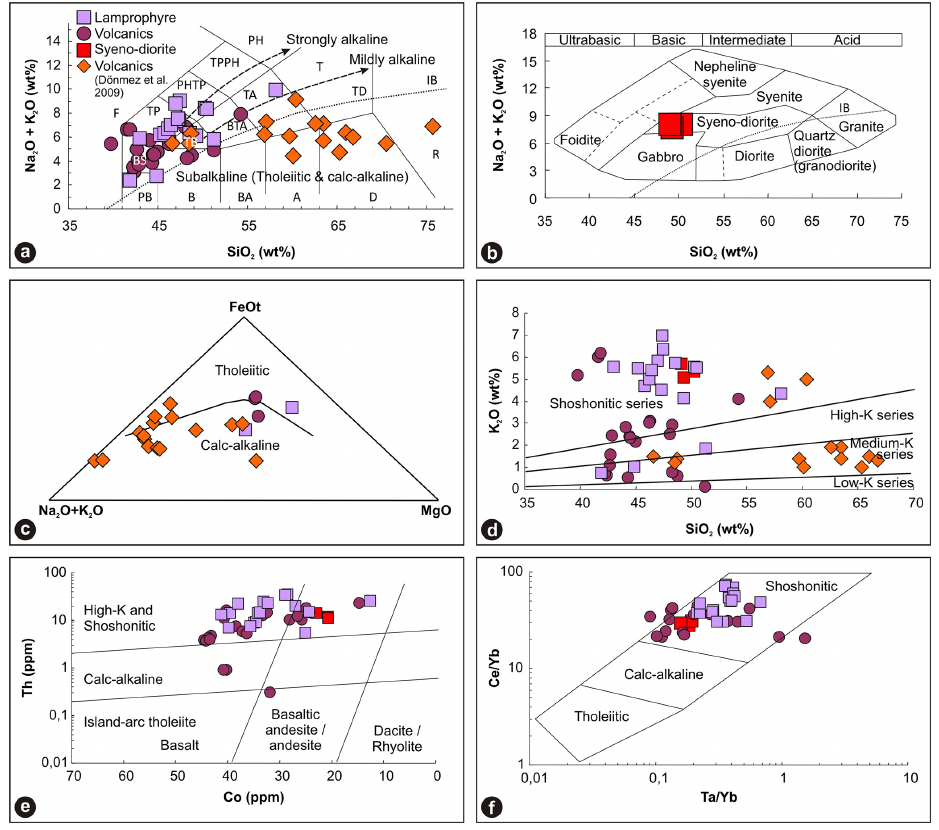
Fig. 14. Geochemical classification of island arc rocks. (a) Total alkali vs. SiO 2 diagram (Le Bas et al., 1986). (b) TAS diagram (Cox et al., 1979) for syenodioritic pluton rocks. (c) Alk–MgO–FeO t diagram (Irvine and Baragar, 1971) of the subalkaline arc volcanic units (Dönmez et al., 2009, and this study). (d) K 2 O vs. SiO 2 diagram (Peccerillo and Taylor, 1976). (e) Th vs. Co diagram (Hastie et al., 2007). (f) Ce/Yb vs. Ta/Yb diagram (Pearce,